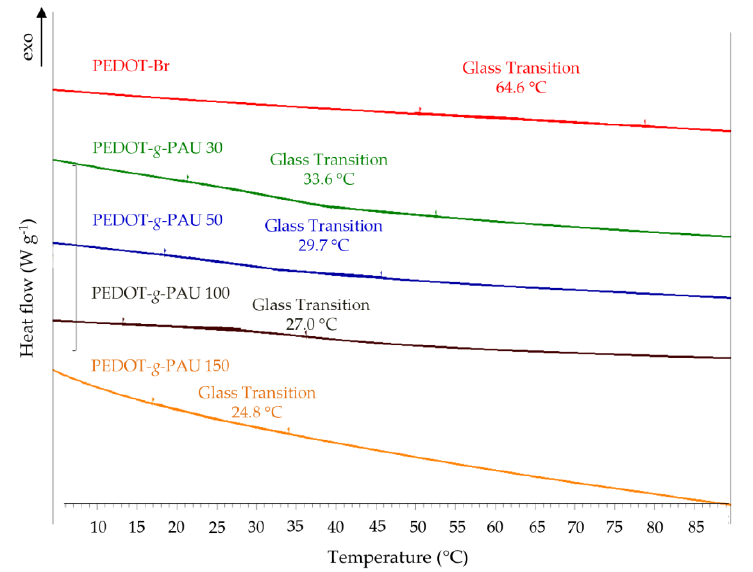
Figure 7. DSC curves of the macroinitiator PEDOT-Br and the obtained graft copolymers PEDOT- g -PAU.